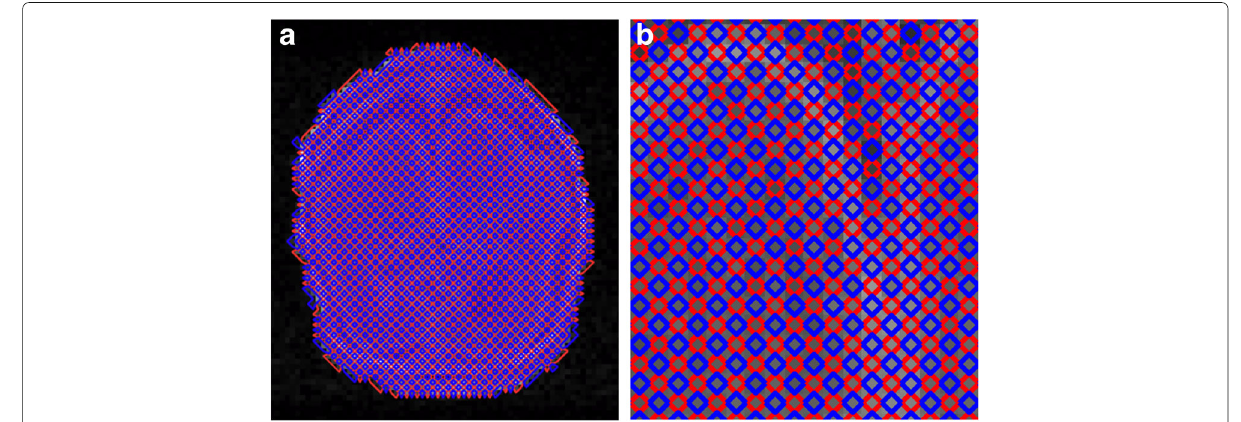
Fig. 3 Initial contour: a ROI-based initial contour and b partial enlarged view